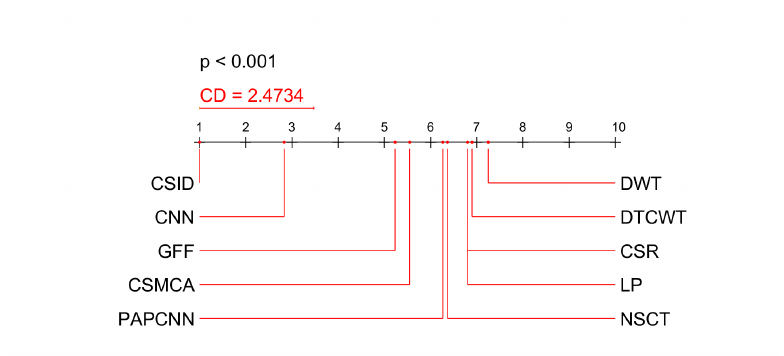
Figure 11. Results of Nemenyi test on different scores evaluating data fusion methods while using six datasets (Data-1 through Data-6). CSID is the proposed